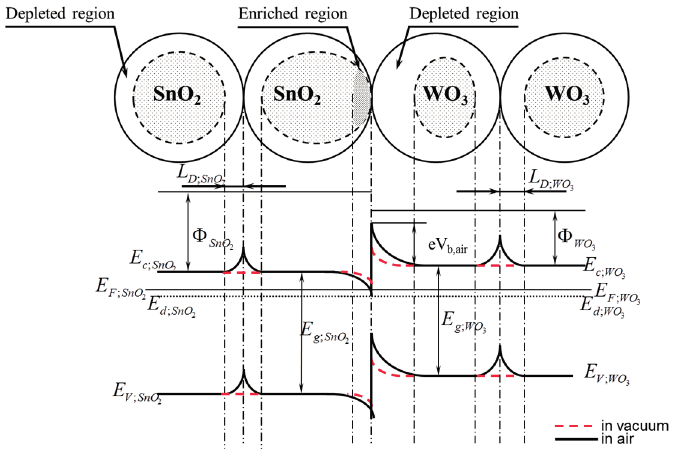
Figure 15. Schematic diagram of the contact of the grains of tin dioxide and tungsten trioxide as well as the band structure of these contacts in vacuum and the atmosphere that contains